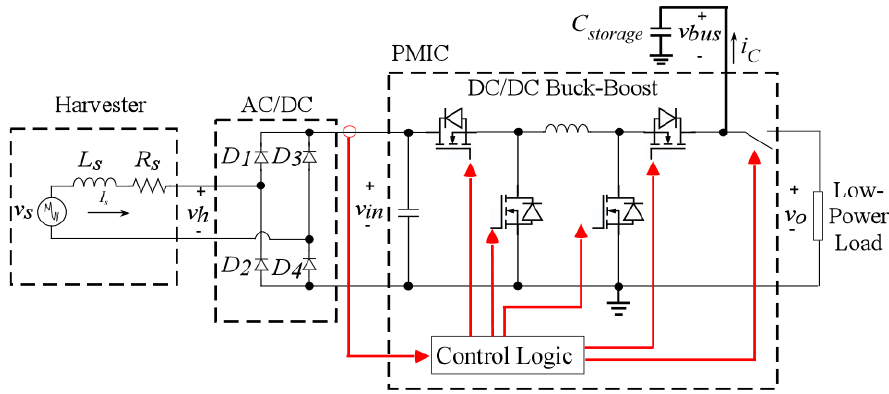
Figure 9. Schematic of the power conversion and management